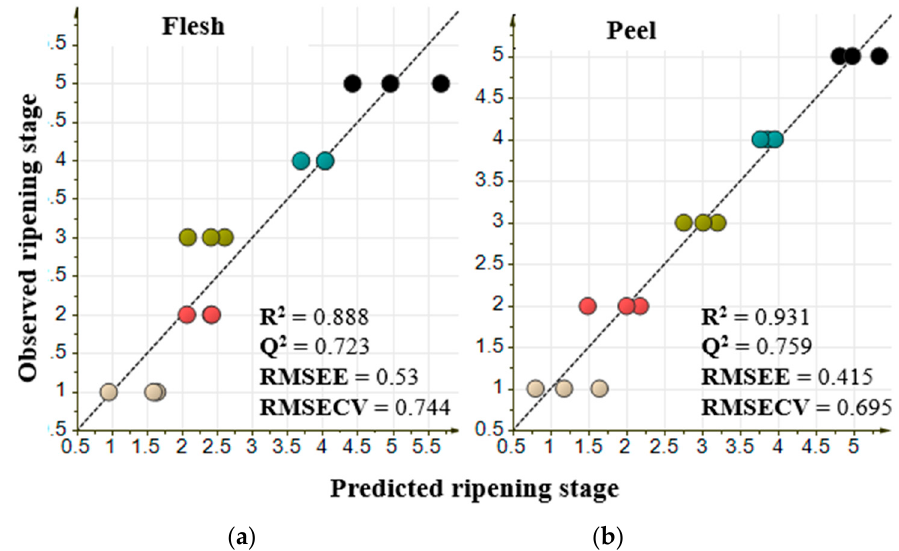
Figure 5. Orthogonal projection to latent structures (OPLS) results from flesh and part of pineapple. Explanatory variables in flesh part are 47 metabolites, while in peel part are 54 metabolites. Response variable for both models is the ripening stages with numbered as follows: C0 stage as 1, C1 stage as 2, C2 stage as 3, C3 stage as 4, and C4 stage as 5. Value of R 2 , Q 2 , RMSEE, and RMSECV were used to